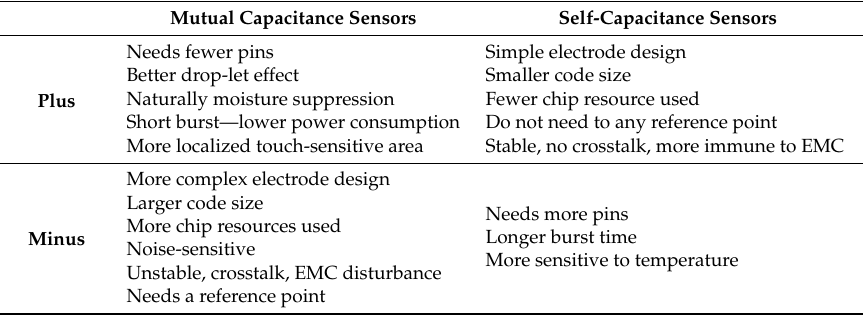
Figure 14. Conducted immunity test ( a ) frequency hopping is used and the carrier frequency varied between 158 kHz and 198 kHz when noise ratio reaches 3 and over; ( b ) on self-capacitance sensors. Table 4. Comparison of mutual and self-capacitance sensors.